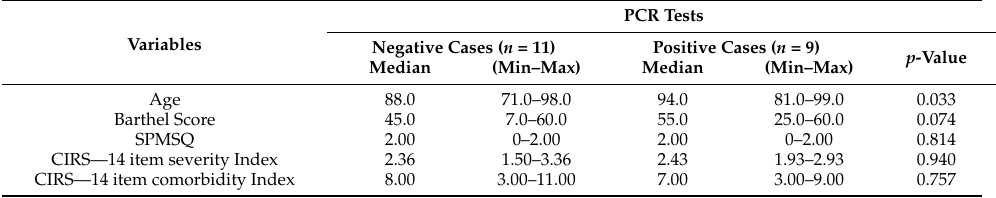
Table 4. Characteristics of the 20 residents vaccinated with the BNT162b2 vaccine (Comirnaty) stratified by COVID-19 test results.